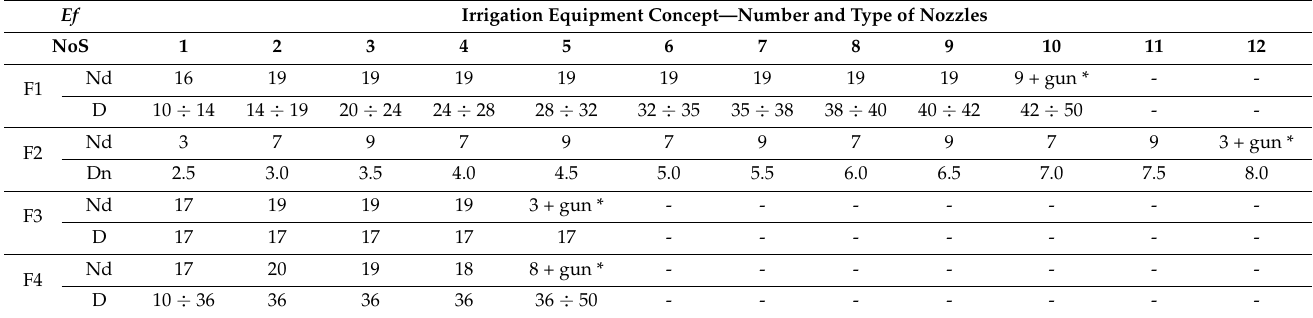
Table 1. The nozzles on the investigated irrigators.